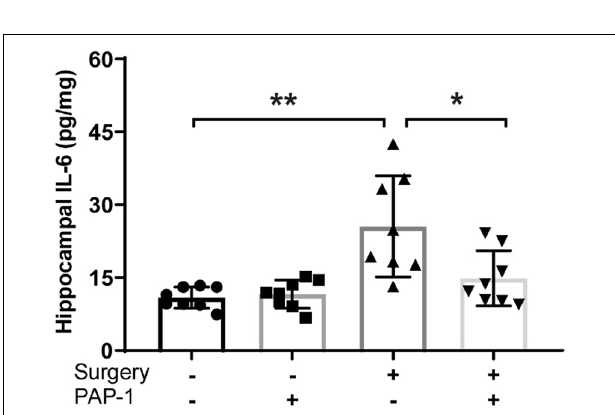
FIGURE 4 | Phenoxyal koxypsoralen-1 (PAP-1) prevents surgery– induced hippocampal inflammation. Applied for Permission to Reproduce Ieng et al. (2020). Mice with diet-induced obesity were randomized to four groups ( n = 8 per group) that received either no surgery or surgery, and either PAP-1 or vehicle. At 24 h after surgery, the animals were killed and hippocampi were removed and assayed for interleukin-6 (IL-6) by enzyme-linked immunosorbent assay. Data were analyzed by one-way analysis of variance followed by Bonferroni post hoc test. * P < 0.001; **P1/40.011 (Ieng et al.,